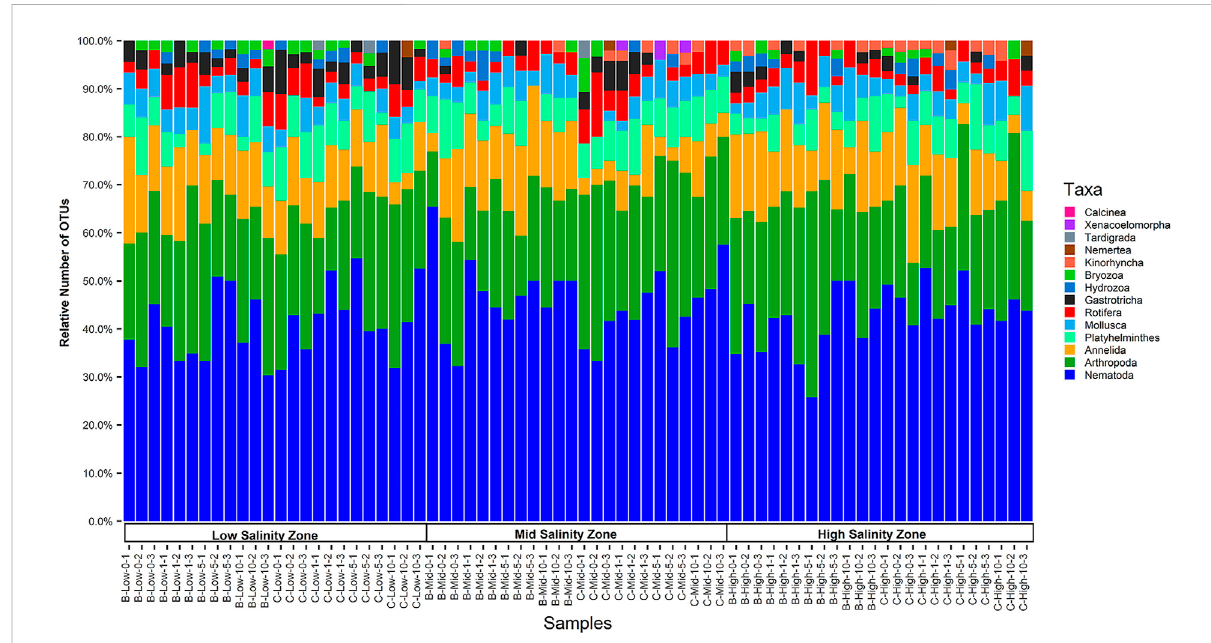
FIGURE 5 Taxa bar plots of the 72 samples collected from the three salinity zones of Barataria and Caillou Bays during July 2018. Each colored section represents the relative proportion of OTU incidences belonging to different phyla within that sample. Phyla are sorted within each bar by the overall highest to lowest relative percentage (from top to bottom). For the x axis, samples are labelled as B (Barataria) or C (Caillou), and Low, Mid, and High for the salinity zones. The number following the salinity zone designation indicates the distance from the edge of the marsh, designated as 0, 1, 5, or 10 m, followed by the transect replicate